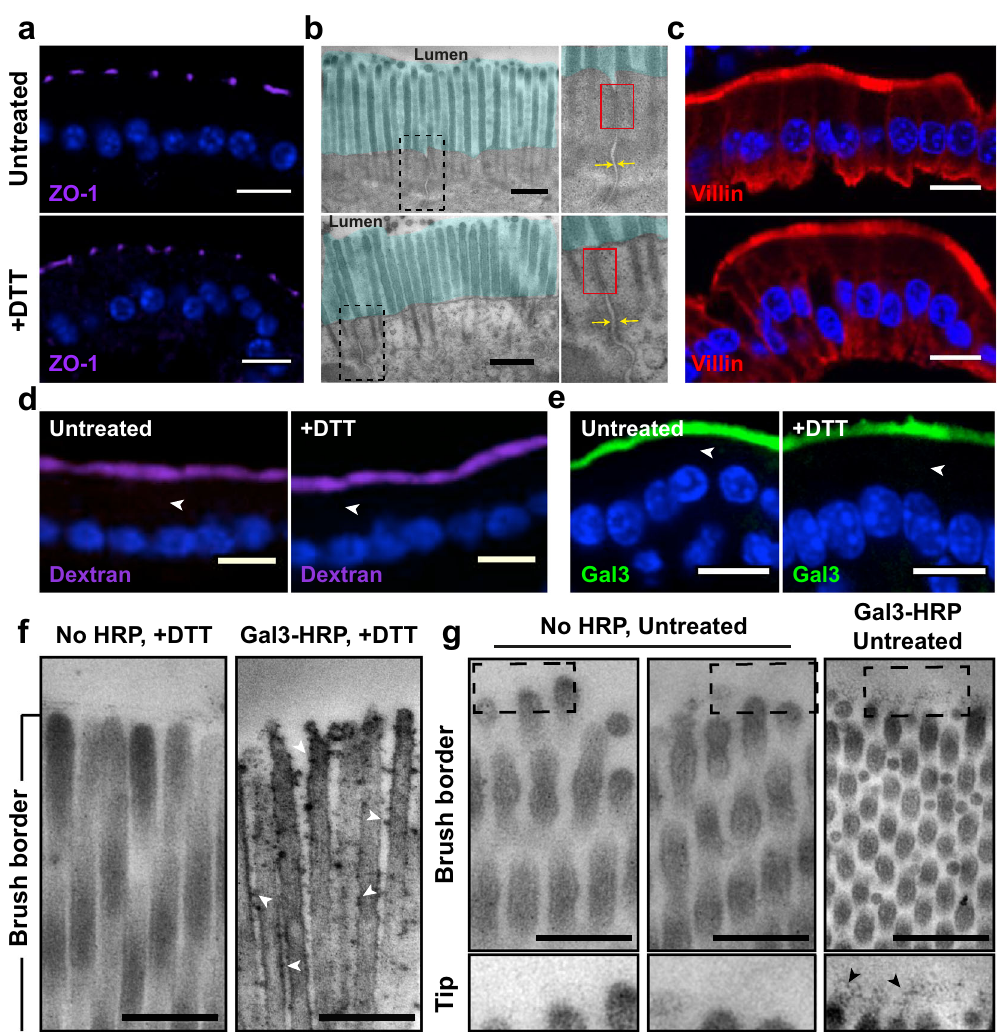
Fig. 2 Interaction of exogenous Gal3 with murine jejunum. a Characterization of the integrity of the DTT-treated mouse jejunum. Apical tight junctions, as visualized using ZO-1, are not altered under DTT treatment conditions. b Electron-dense tight junctions (red rectangles) have unperturbed morphology and localization in DTT treatment conditions, and the cohesiveness of lateral cell – cell contacts (yellow arrows) are well preserved, as analyzed by electron microscopy. The turquoise blue highlights the microvilli (brush border) zone. c The microvilli marker villin was used to label the apical integrity of the epithelium. Note that villin and ZO-1 are both normally localized under DTT treatment conditions. Nuclei in blue. d 10-kDa dextran was incubated at 4 °C with DTT-treated murine jejunum to analyze tissue permeability, which was not altered under DTT treatment conditions. e Gal3 was incubated at 4 °C with DTT-treated murine jejunum. As with 10-kDa dextran, no transcellular leakage was observed under DTT treatment conditions (white arrowheads). Nuclei in blue. f DTT treatment is required for Gal3 to reach the brush border. DTT-permeabilized jejunum that was incubated with Gal3-HRP shows HRP-positive signal at the level of microvilli (dark dotted signals, white arrowheads). This labeling is speci fi c as it was not observed when incubations were done in the absence of Gal3-HRP (No HRP). g Without DTT treatment, Gal3-HRP signal is trapped within the mucus layer. Granular dark dotted structures are detected at the far tip part of the microvilli, further visible under higher magni fi cation (right image and zoom, black arrowheads). In contrast, no signal is detected in the absence of Gal3-HRP (two left images and zooms). Scale bars = 10 μ m for immuno fl uorescence, and 1 μ m for electron microscopy